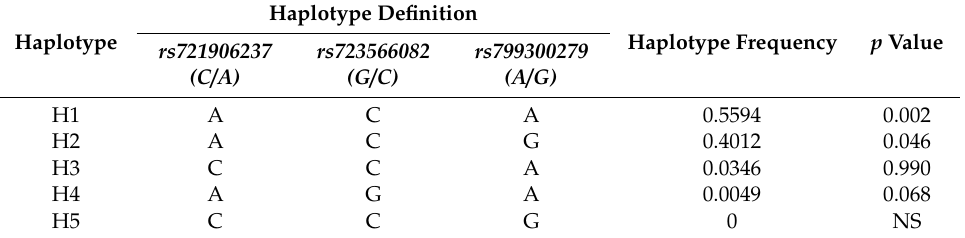
Table 6. Estimated haplotype frequencies of selected N’Dama-specific CD14 gene promoter SNPs.